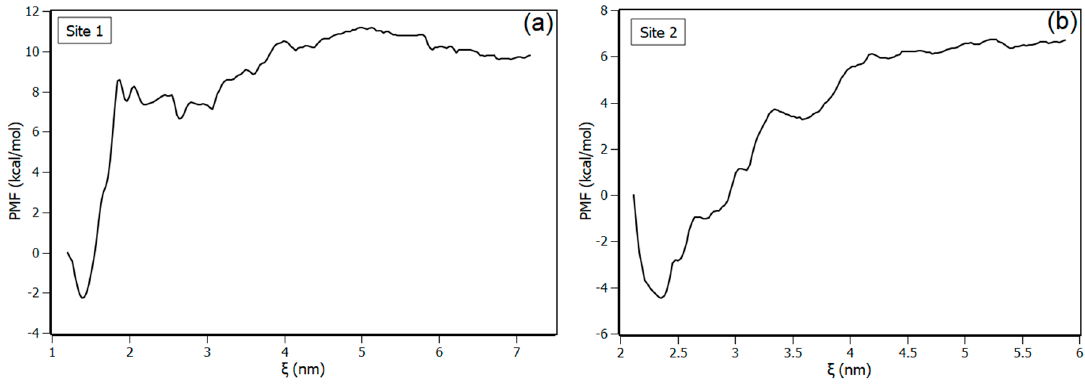
Figure 9. Potential of mean force (PMF) for the dissociation of piperine from NBD, ( a ) for binding site 1 and for ( b ) binding site 2.